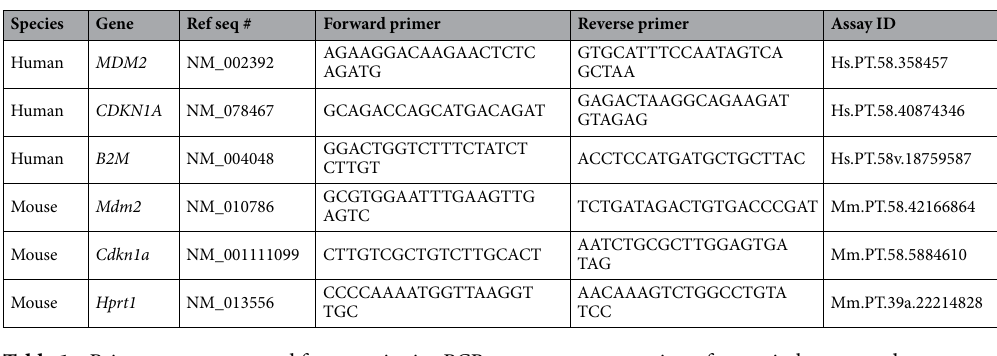
Table 1. Primer sequences used for quantitative PCR to measure expression of genes in human and mouse cancer cell lines.